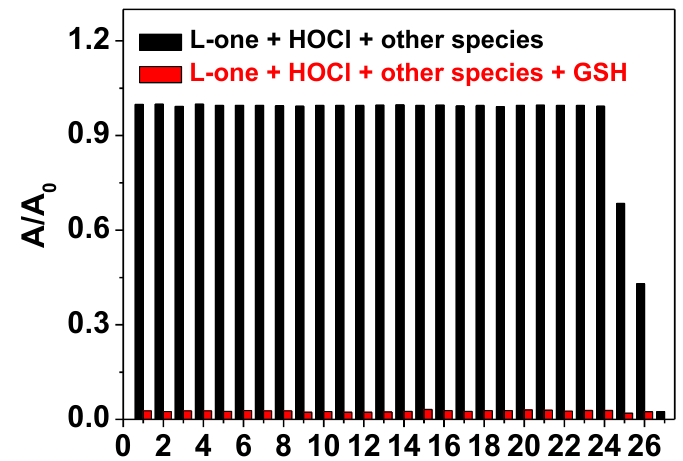
Figure 5. UV-vis absorption spectra of L-one (10 μM) in the presence of various analytes (500 μM) in PBS aqueous buffer (DMF:PBS = 7:3, 20 mM, pH = 7.4): 1. Leu, 2. His, 3. Val, 4. Tyr, 5. Gerl, 6. Try, 7. Phe, 8. Leu, 9. Thr, 10. Lys, 11. Gly, 12. Pro, 13. Ary, 14. Gln, 15. Asn, 16. Asp, 17. Ala, 18. Hcy, 19. Cys, 20. S 2 – , 21. HSO 4 – , 22. HSO 3 – , 23. SO 42 – , 24. SO 32 – , 25. Met, 26, Vc, 27. GSH.